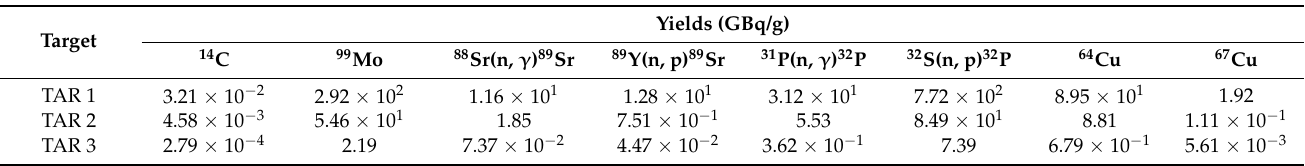
Table 1. Yield of medical radioisotopes from TAR1 to TAR3 at a fusion power of 2.0 GW, an irradiation time of 365 d, and a cooling time of 1